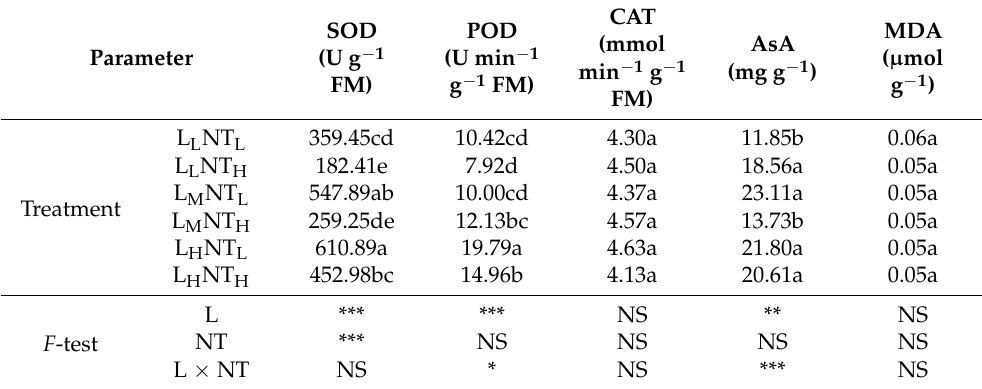
Table 2. Effect of light intensity (LI) and night temperature (NT) on the antioxidants and MDA of cherry tomato seedlings and LI and NT interaction